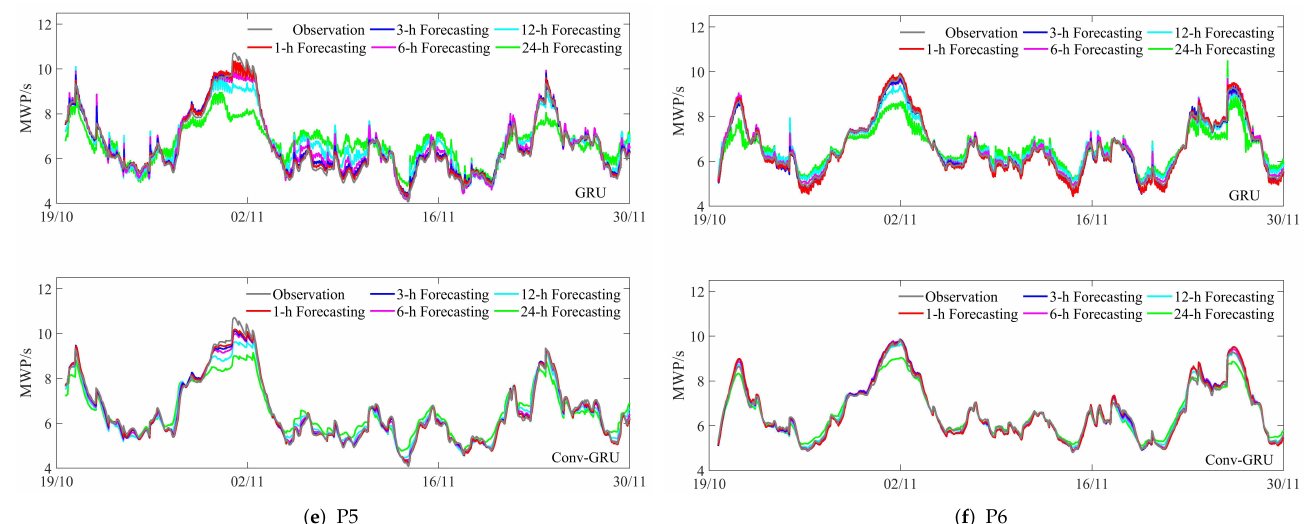
Figure 8. Time series plots of the GRU and Conv-GRU models at six locations, where ( a – f ) represent P1-P6. Each subplot is split into two plots, the upper one showing the experimental results obtained from the GRU model, on the contrary, the lower one reflecting the content obtained by the Conv-GRU model. The gray and red (blue, magenta, cyan, green) curves depict the observation and 1-h (3, 6, 12, and 24-h) forecasting under the different models, respectively. The X-axis is the time series corresponding to the test set in